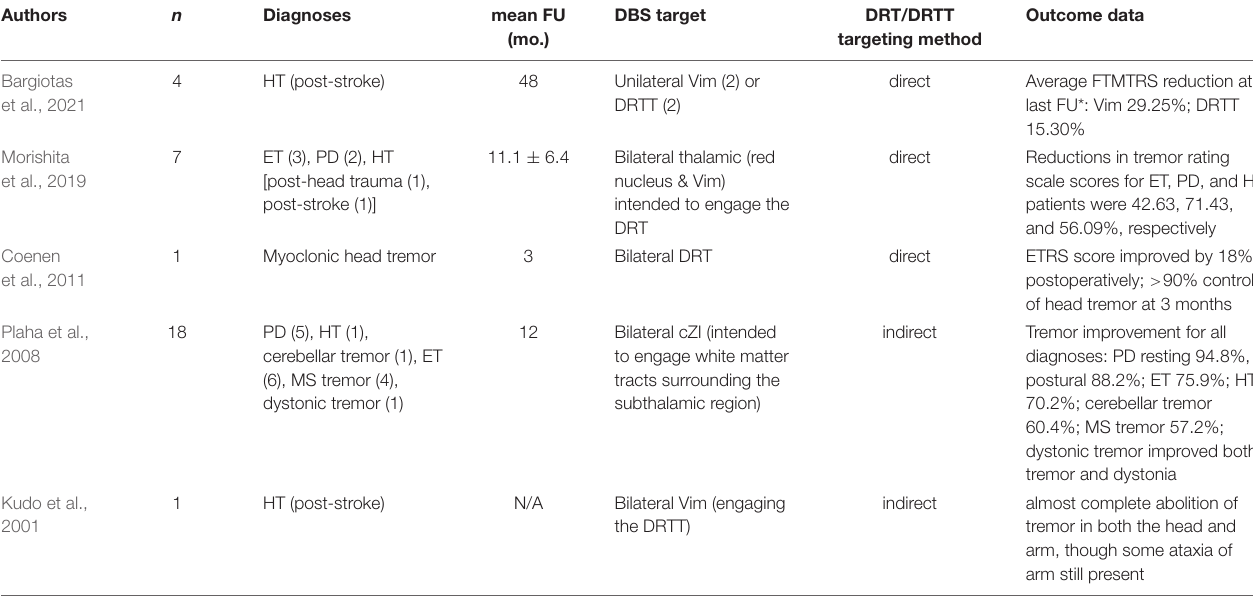
TABLE 2 | Literature review of patients with rare, acquired tremor syndromes who underwent DBS of the DRT/DRTT.